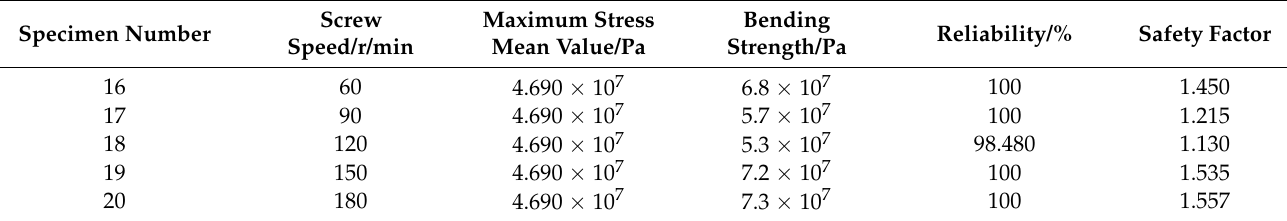
Table 6. Simulation results of the screw speed on